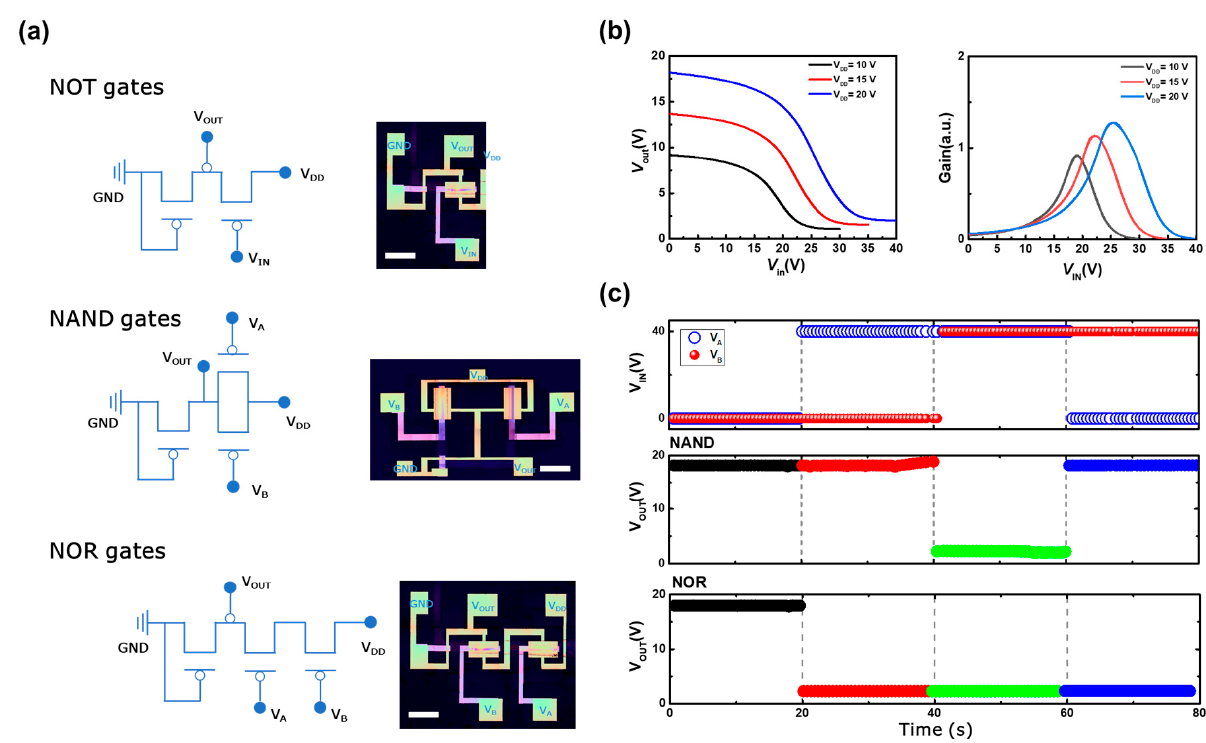
Figure 5. ( a ) Circuit diagram and OM image of integrated devices (scale bar indicates 2 mm). ( b ) VTC and gain curve of NOT gates. ( c ) Output voltage values corresponding to input voltages (V A and V B ).